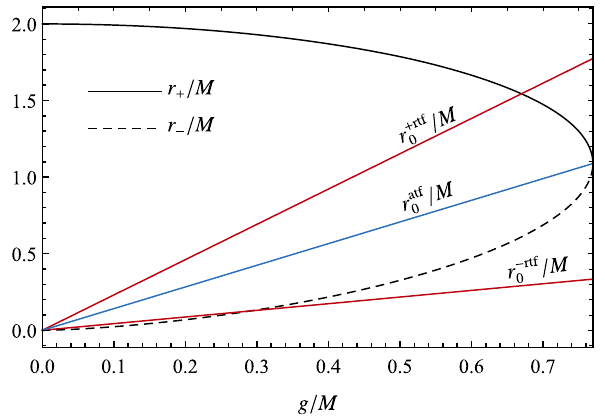
Fig. 3 Radial coordinate of the event horizon ( r + ), of the Cauchy hori- zon ( r − ) and the radial coordinates where the radial ( r ) tidal forces vanish, plotted as functions of the monopole charge ( r atf 0